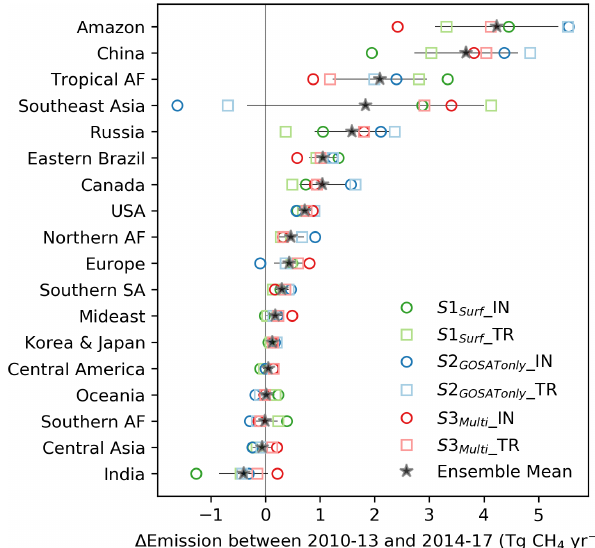
Figure 7. Regional emission changes between 2010–2013 and 2014–2017 ranked from the highest to the smallest changes. The color-coded markers represent individual inversions, the gray stars represent the ensemble mean, and the horizontal error bars denote the standard deviation of all versions. The regional mask is shown in Fig.